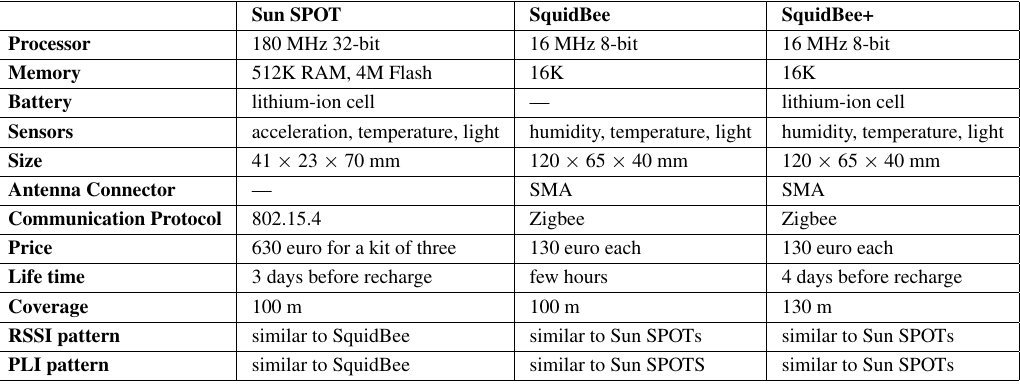
Table 4. Comparison of physical